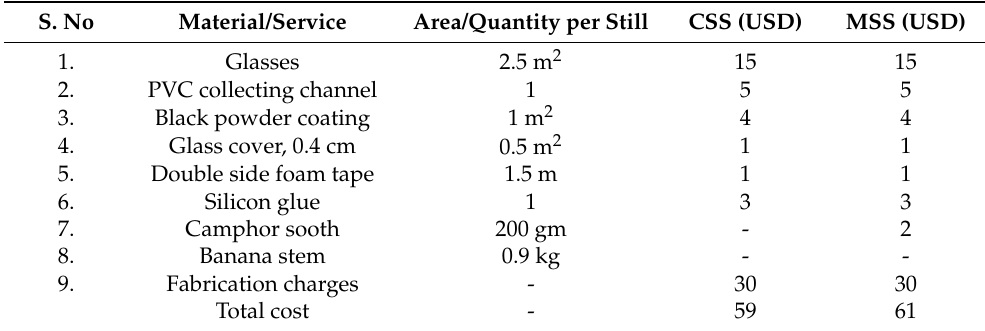
Table 2. Costs associated with the manufacture of solar stills.